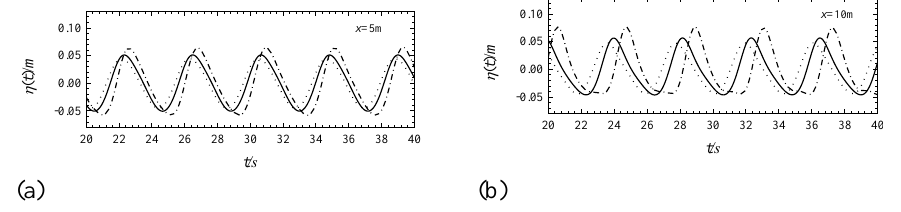
Figure 13. Wavefront ratios at x = 5 m ( a ) and x = 10 m ( b ) for different flow conditions in the MIKE 21 BW model (solid line for no-current, dashed line for downstream, dotted line for